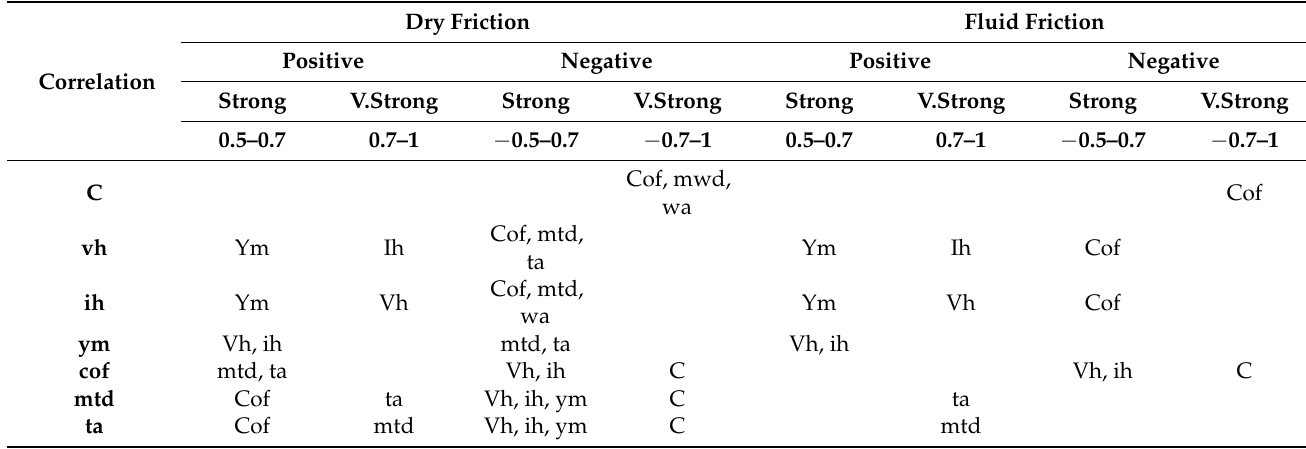
Figure 7. Heatmap for fluid friction. Table 8. Significant correlations between the